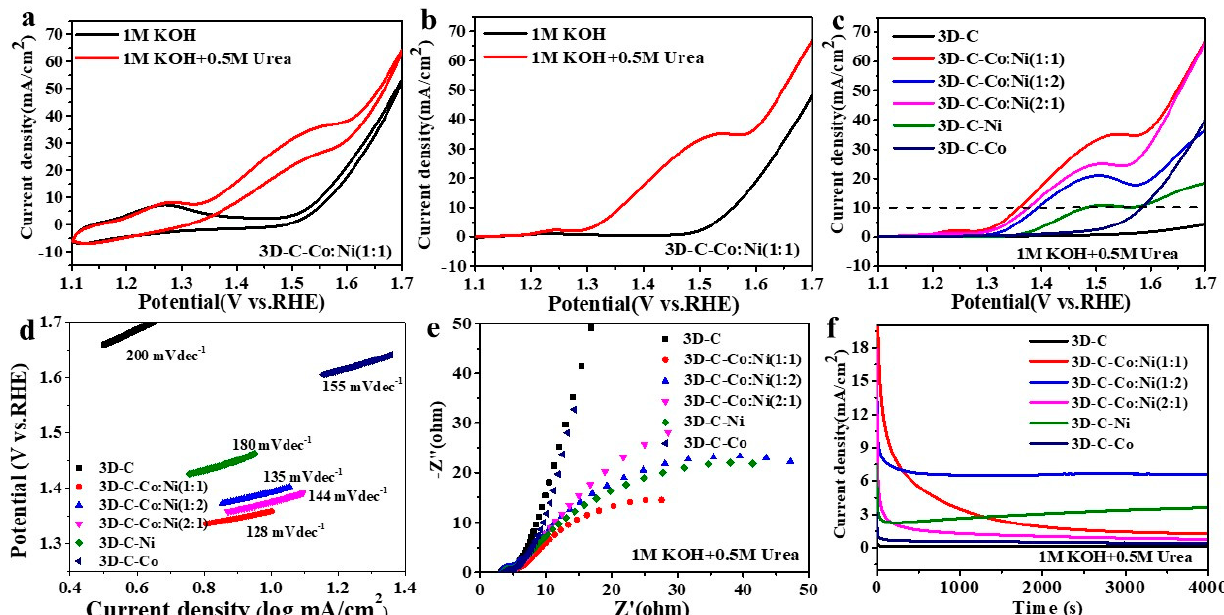
Figure 3. ( a ) CV and ( b ) LSV profiles of 3D-C-NiCo (1:1) for UOR with or without urea, ( c ) LSV profiles for different catalysts, ( d ) the Tafel slope from LSV curves, ( e ) Nyquist plots of different catalysts, and ( f ) the stability test of 3D-C-NiCo (1:1) for UOR.